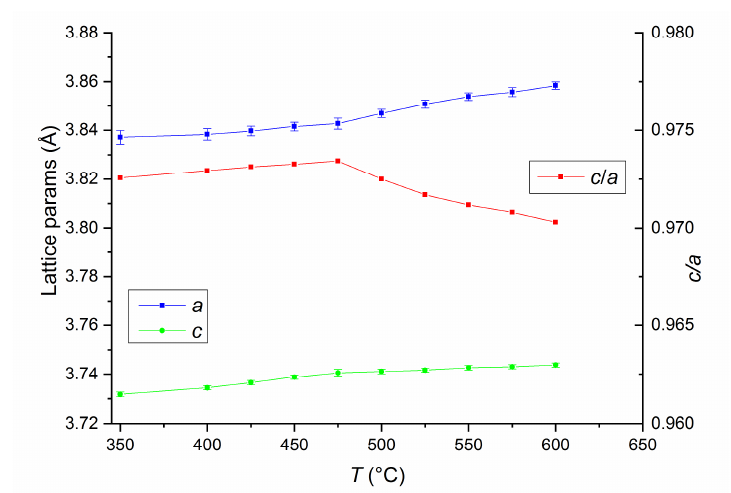
Figure 5. Tetragonal lattice parameters ( a and c ) and the c/a parameter as a function of temperature obtained from the full-profile fitting of the synchrotron X-ray